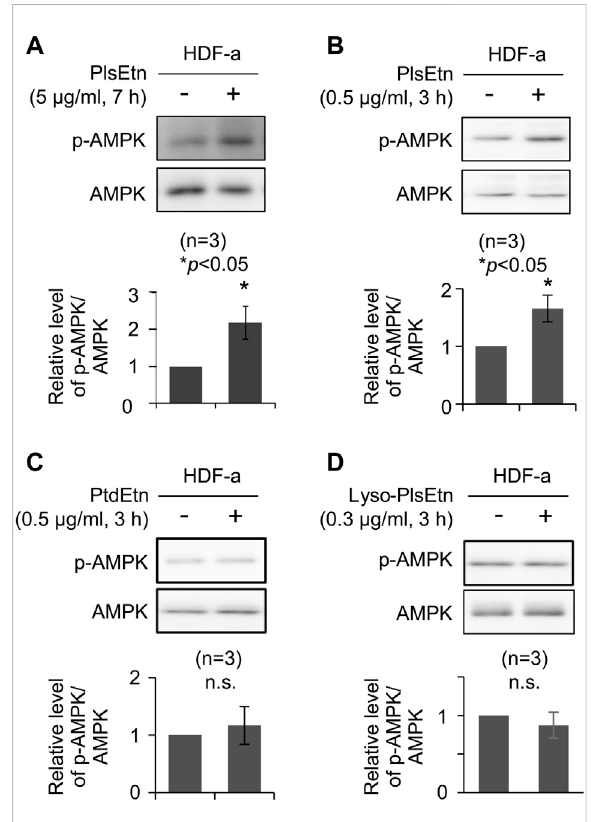
FIGURE 1 PlsEtn promote phosphorylation of AMPK in HDF-a cells (A,B) Immunoblot for phosphorylated AMPK (p-AMPK) and total AMPK in HDF-a cells cultured in the presence of 5 μ g/ml (A) or 0.5 μ g/ml (B) PlsEtn. The amount of p-AMPK to total AMPK is represented in the lower panel (n = 3) (C,D) Representative immunoblot for p-AMPK and AMPK in HDF-a cells treated with phosphatidylethanolamine (PtdEtn) (C) or0.3 μ g/mllyso-plasmalogens(Lyso-PlsEtn) (D) Amount of p-AMPK to total AMPK is represented in the lower panel ( n =